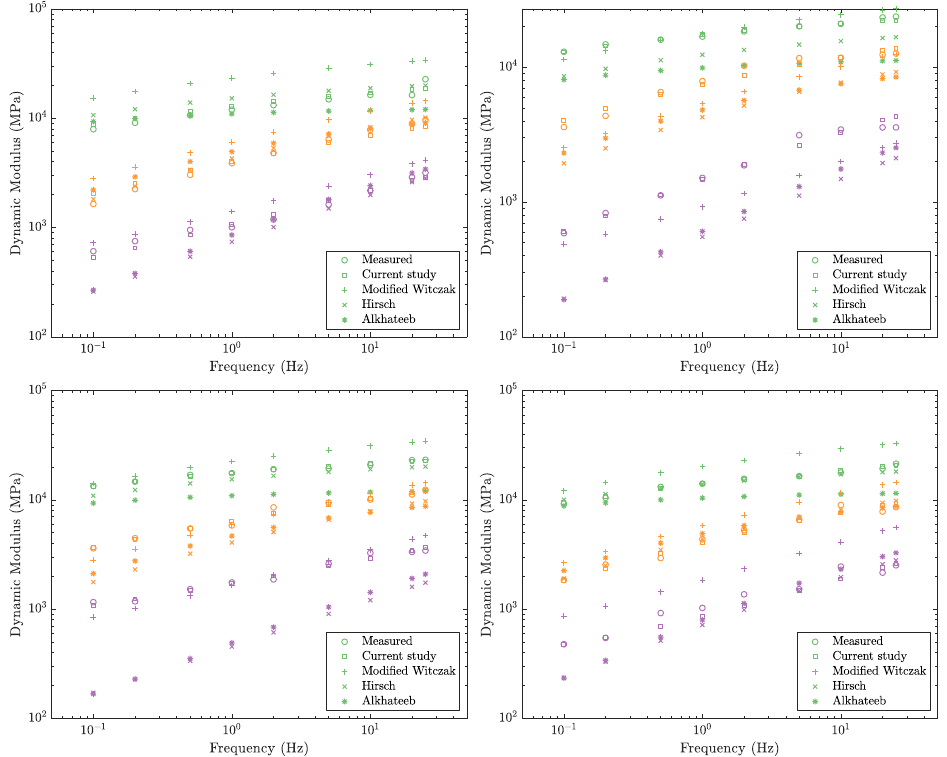
Figure 7. Comparing the measured and predicted (current study and conventional models) dynamic modulus. Results are presented at three temperatures. Green color indicates 0.4 ◦ C, Orange color indicates 17.1 ◦ C, and Purple color indicates 33.8 ◦